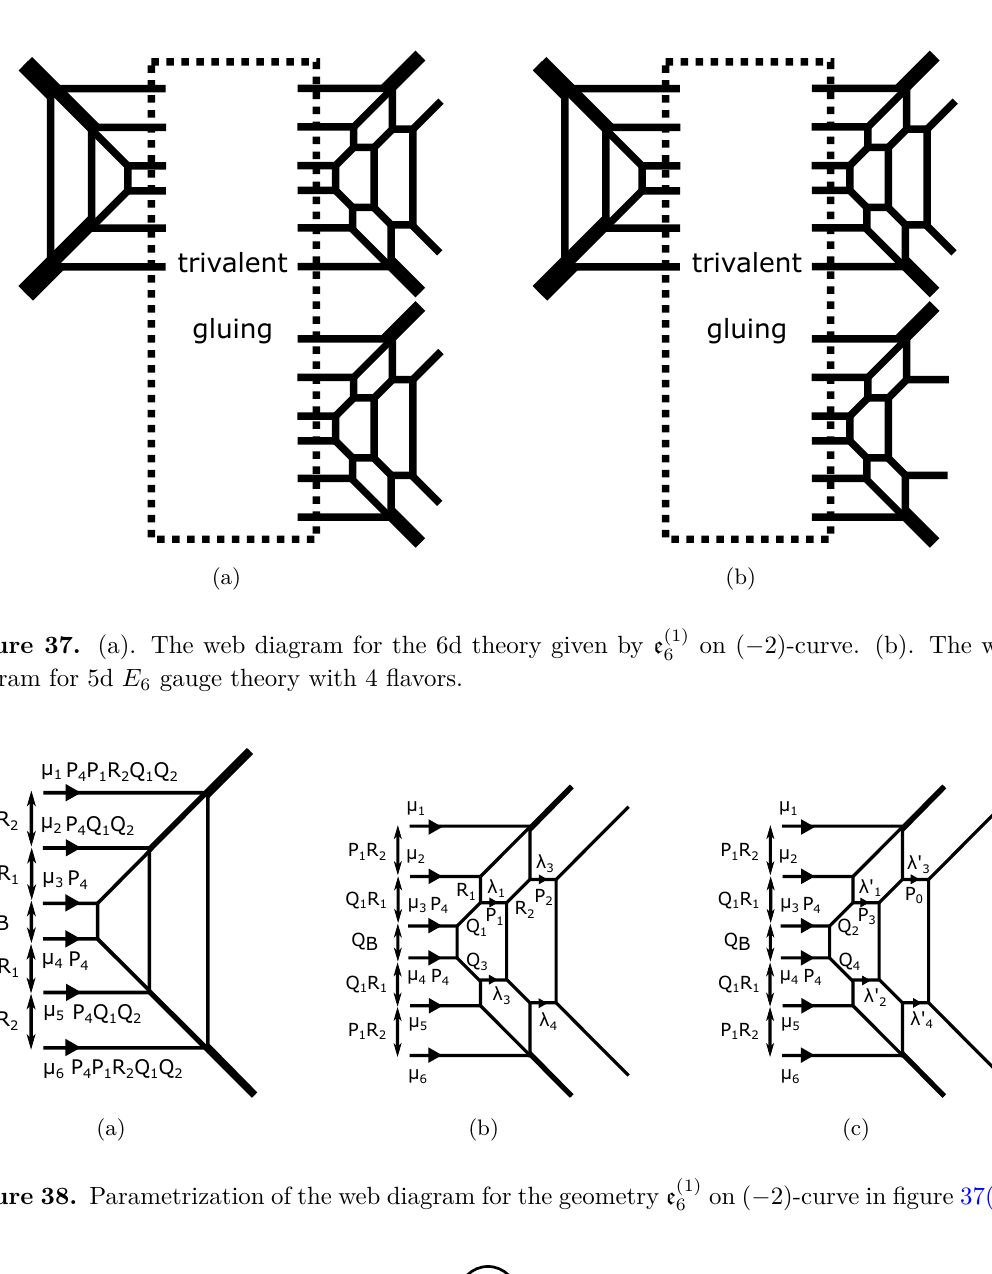
on ( − 2) -curve in figure 37(a). 6